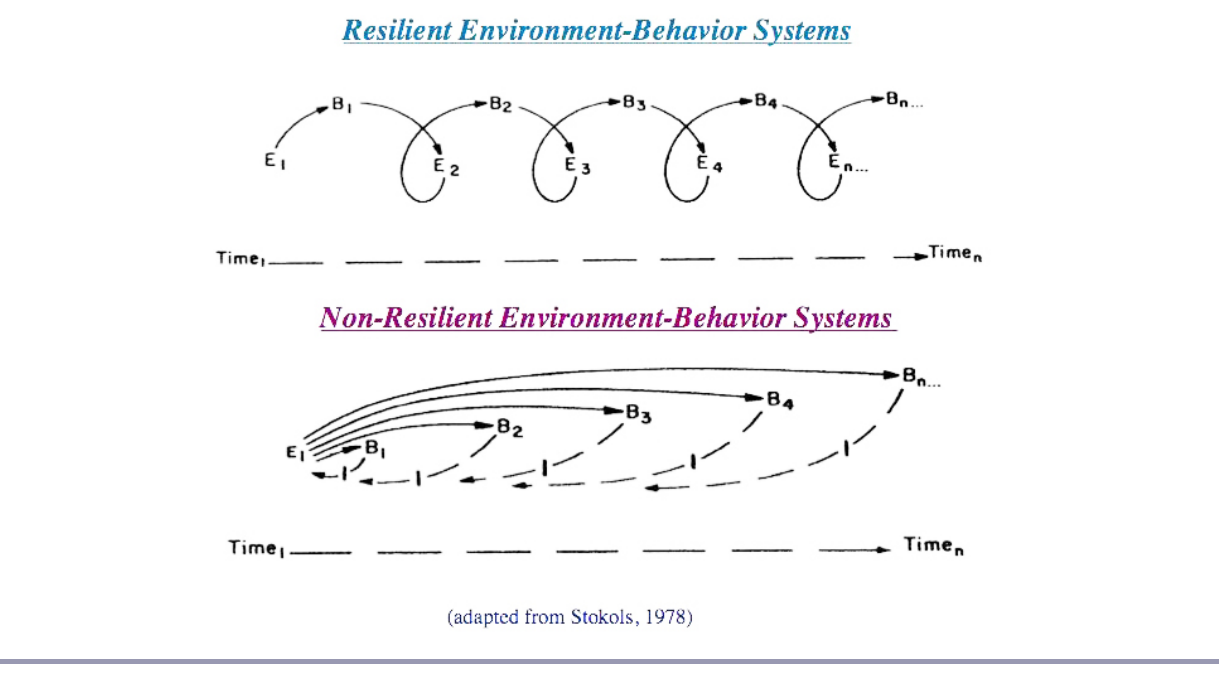
Fig. 1 . Schematic representations of human–environment